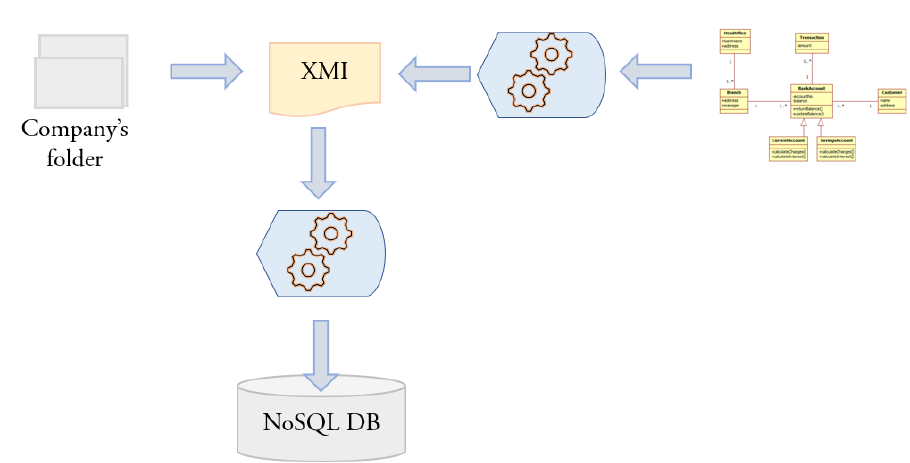
Figure 6. Paths to feed a metadata repository about UML class